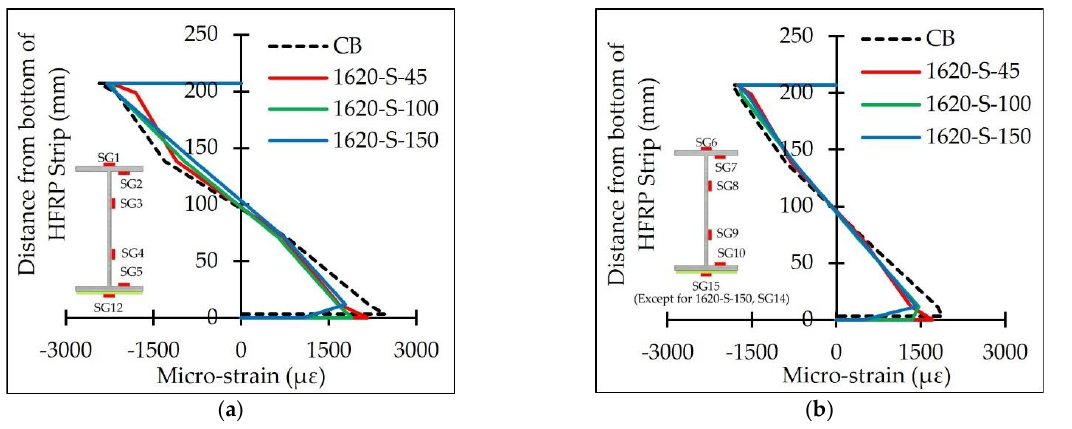
Figure 23. Strain profiles of CB, 1620-S-45, 1620-S-100 and 1620-S-150 at 310 kN at: ( a ) mid-segments; ( b ) edge-segments.